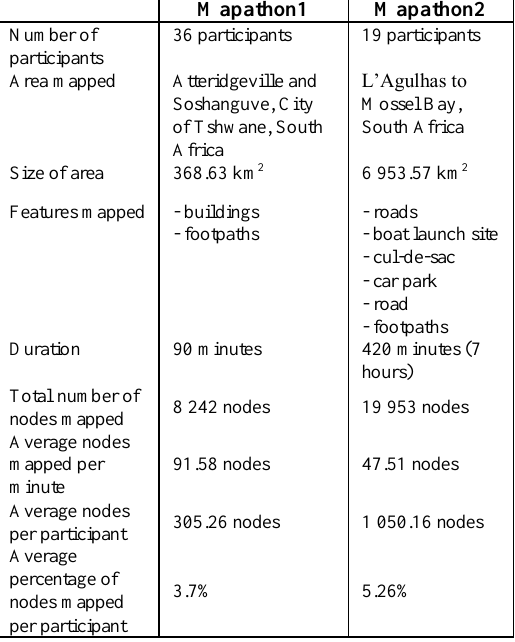
Table 4. Overview of mapathon